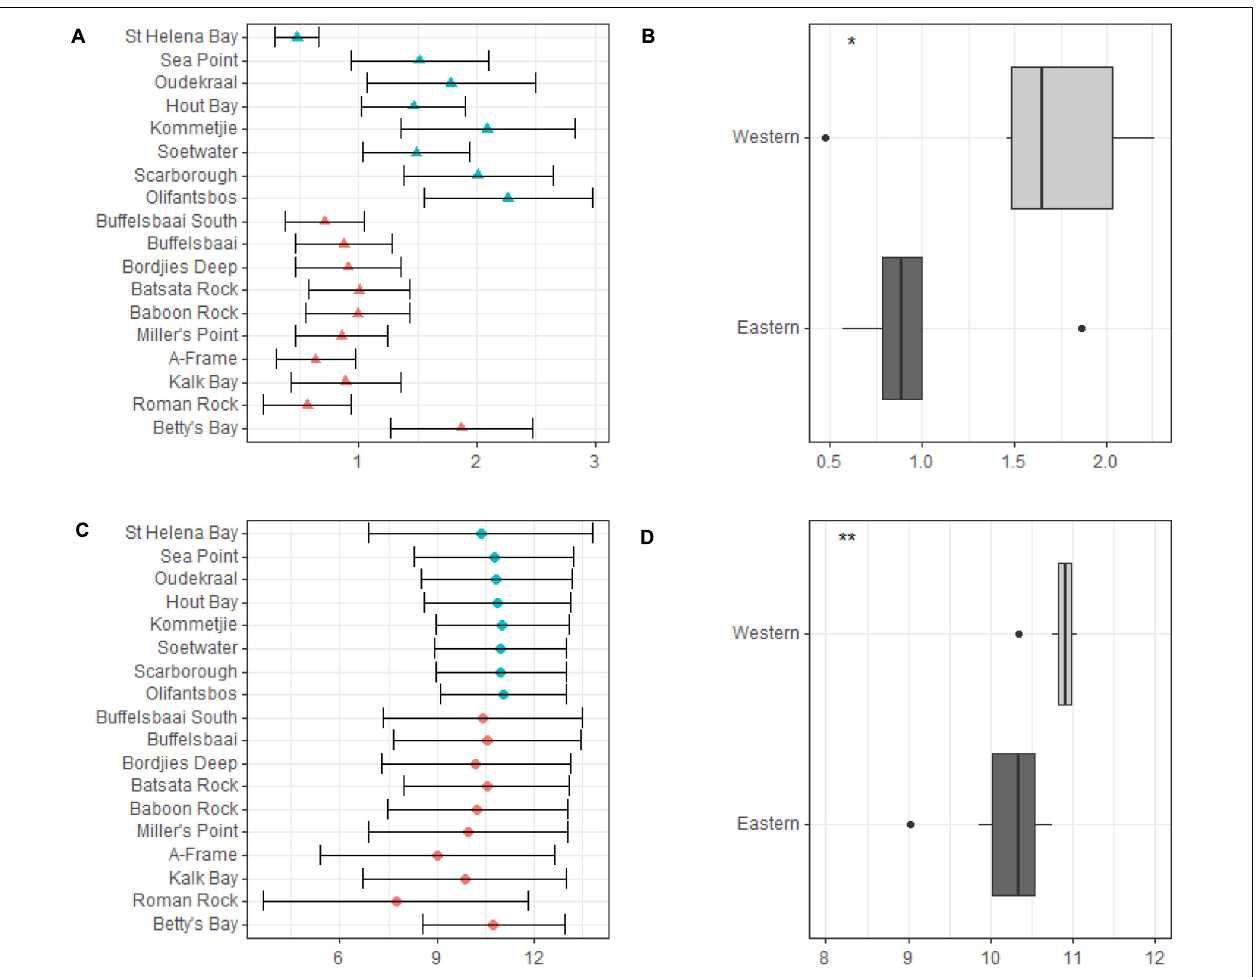
FIGURE 4 | Mean significant wave height (meters) and mean significant peak period (seconds) across sites and by region. Annual mean significant wave height across sites is presented in panel (A) and is represented by solid triangles and standard deviation by the whiskers. Differences in annual mean significant wave height between regions are presented in panel (B) . Annual mean significant peak period across sites is presented in panel (C) and is represented by solid dots and standard deviation by whiskers. Differences in annual mean significant peak period between regions are presented in panel (D) . Significance levels are as follows: * represents ≤ 0.05, ** represents ≤ 0.01, *** represents ≤ 0.001, **** represents ≤